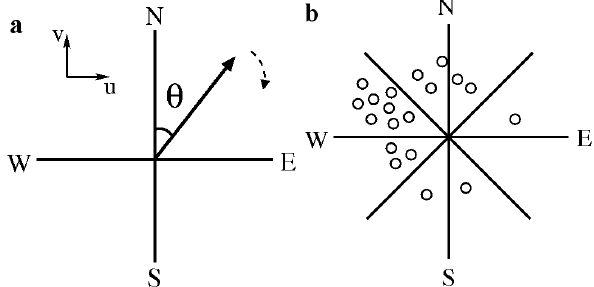
Fig. 2. For each 1 ◦ × 1 ◦ point, τ is expressed as a function of wind direction. The blue curve represents the case where τ depends strongly on wind direction and so has a large σ τ . The red curve represents the case where τ does not depend on wind direction and so has a small σ τ . The τ max shows the wind direction in which the τ has the largest value.